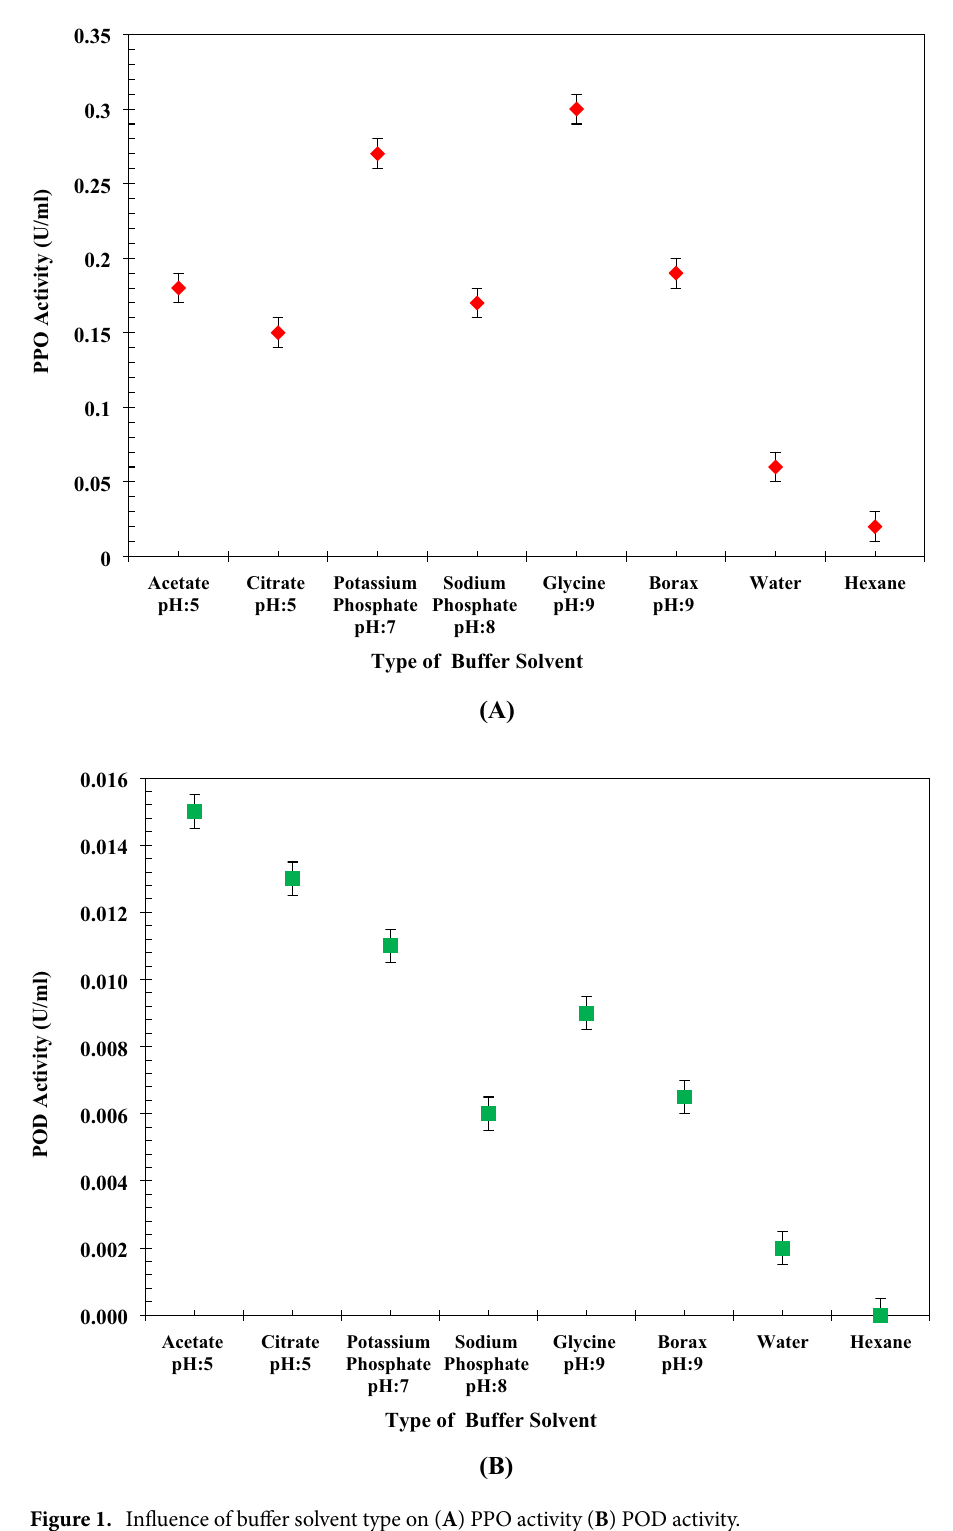
Figure 1. Influence of buffer solvent type on ( A ) PPO activity ( B ) POD